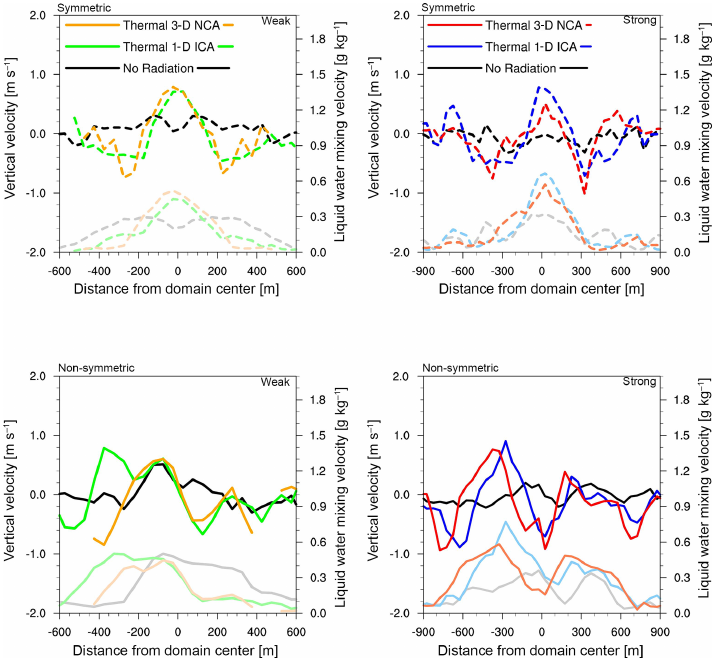
Figure 5. Height- and time-averaged transects of liquid water mixing ratio and vertical velocity. Liquid water mixing ratio is shown in pale colors on the bottom; the vertical velocity is shown in middle of each figure. The corresponding axes are on the right and left, respectively. The time averaging was performed over 3min at around 60min simulation time. The vertical average was taken in the middle of the vertical extent of the cloud to cover cloud side areas. Dashed lines show the symmetric cloud; solid lines show the non-symmetric cloud.